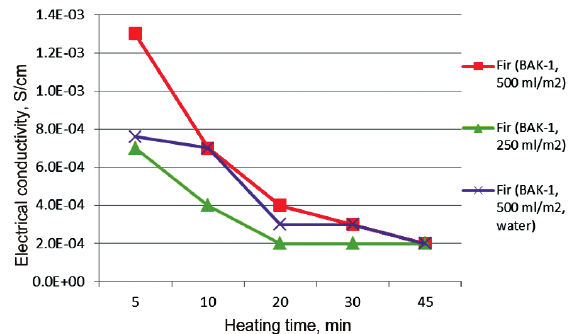
fig. 10. the dependency of the average electrical conductivity on heating time for media 6, 7 and 8